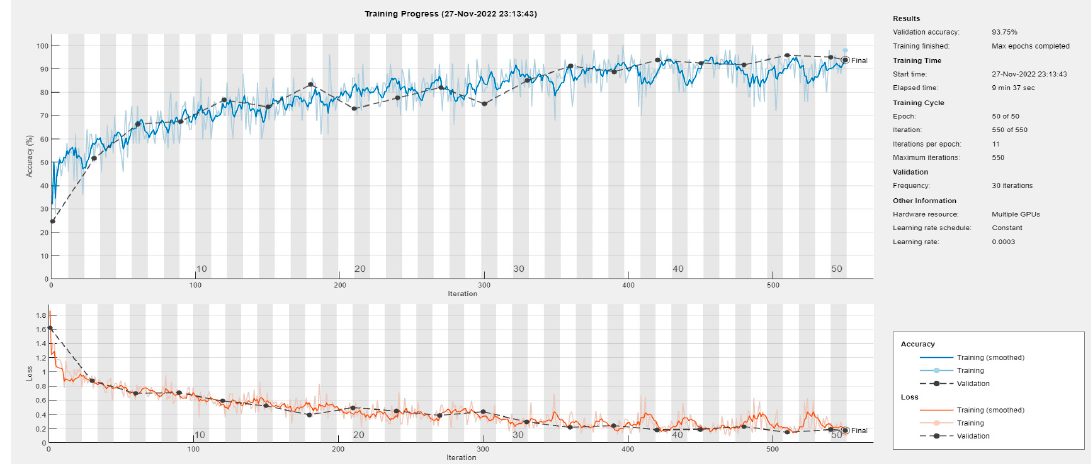
Figure 7. Example of range-Doppler maps generated with speeds of 225 m/s and different positions of (respectively, from the left to right) 1, 2, 3 targets.